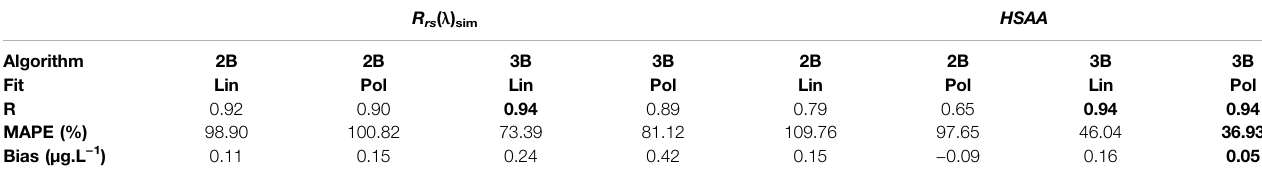
TABLE 3 | Statistical results obtained from Monte Carlo simulation for chlorophyll-a algorithms using 2-band (2B) and 3-band (3B) algorithms with linear (Lin) and quadratic polynomial (Pol) fi tting.